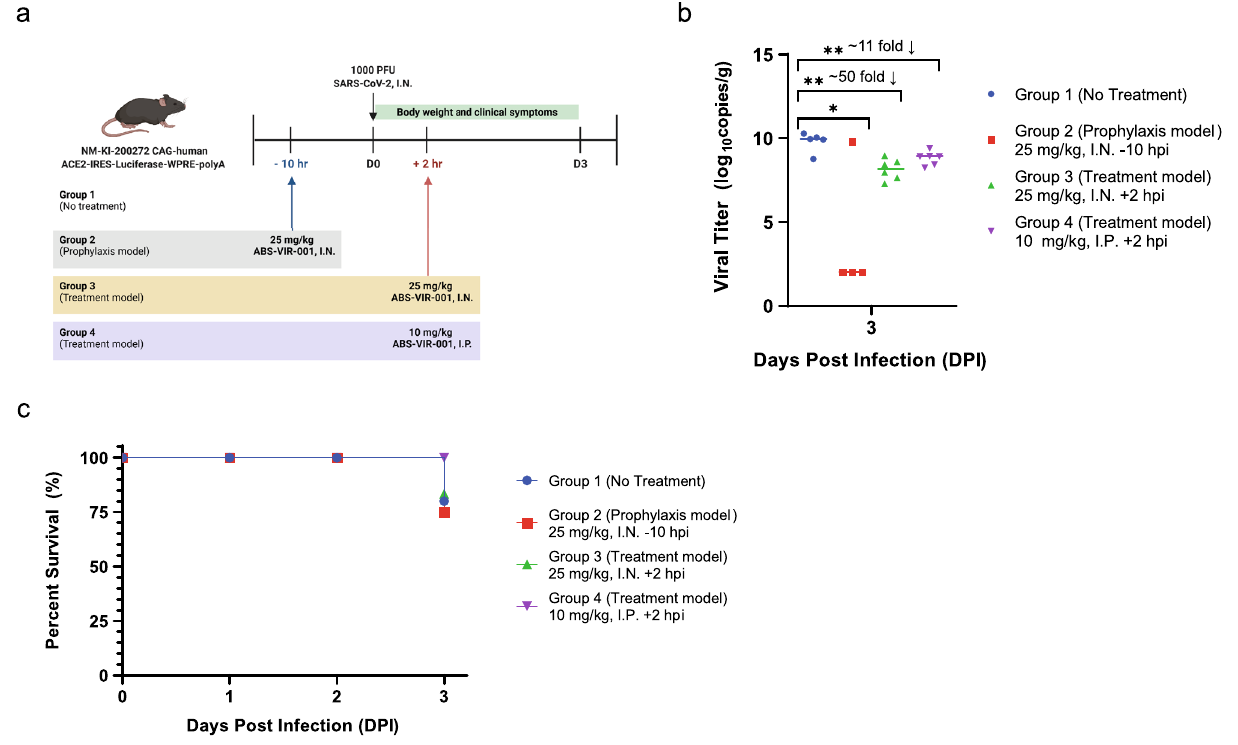
Figure 2. ABS-VIR-001 prevents SARS-CoV-2 infection and death and decreases viral burden in huACE-2 mice challenged with authentic SARS-CoV-2. Human ACE-2 expressing mice were challenged with SARS- CoV-2 (intranasally, I.N.) and were randomly divided into 4 groups and treated as indicated and observed for body weight and clinical symptoms. ( A ) Workflow of the SARS-CoV-2 animal study. B) On D3, the lungs of the mice were harvested and viral titers were assessed by RT-qPCR. Statistical significance was calculated by a student t-test and a P value of < 0.05 was considered statistically significant. This data shows that viral titer was not detected (3 out of the 4 mice in the prophylaxis Group 2) or significantly decreased in all mice treated with ABS-VIR-001, indicating that ABS-VIR-001 is a potent prophylactic and treatment for SARS-CoV-2 infection. ( C ) After D3, all mice within the I.P. Treatment group survived (Group 4) or showed similar survival (Groups 2 and 3) as the no treatment group (Group 1), indicating that ABS-VIR-001 is well-tolerated and